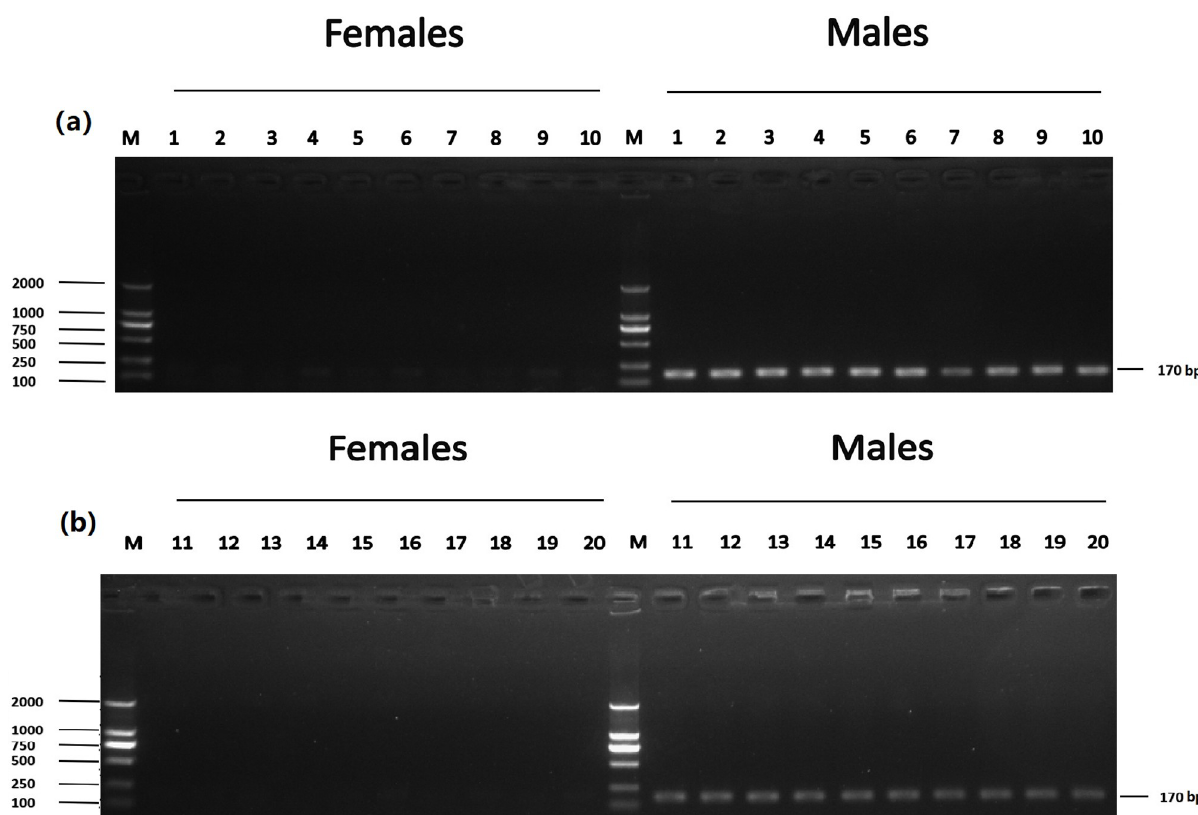
Fig 7. Identification of a male-specific tag, DNA fragment, amplified with Tag8821444. The left shows DL 2000 DNA marker sizes; the right shows fragment sizes.